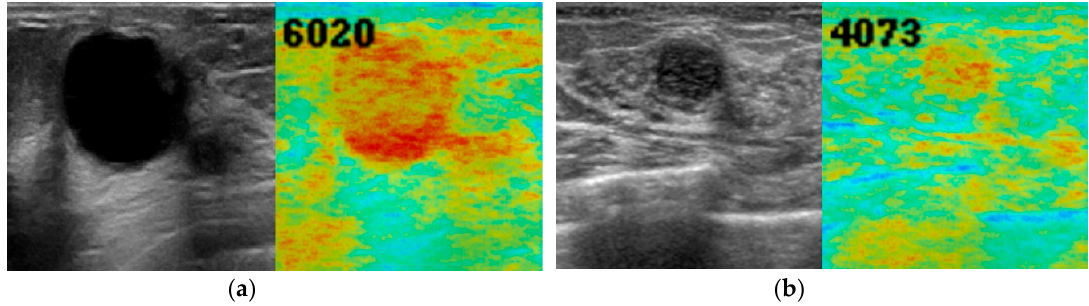
Figure 4. B-mode ultrasound images (left, grey) and anomaly score images (right, color) of normal breast tissue. A 45-year-old woman ( a ) and a 63-year-old woman ( b ) with normal breast tissue. There was almost no abnormal color noted, and the anomaly score was low (3136 and 3433, respectively).